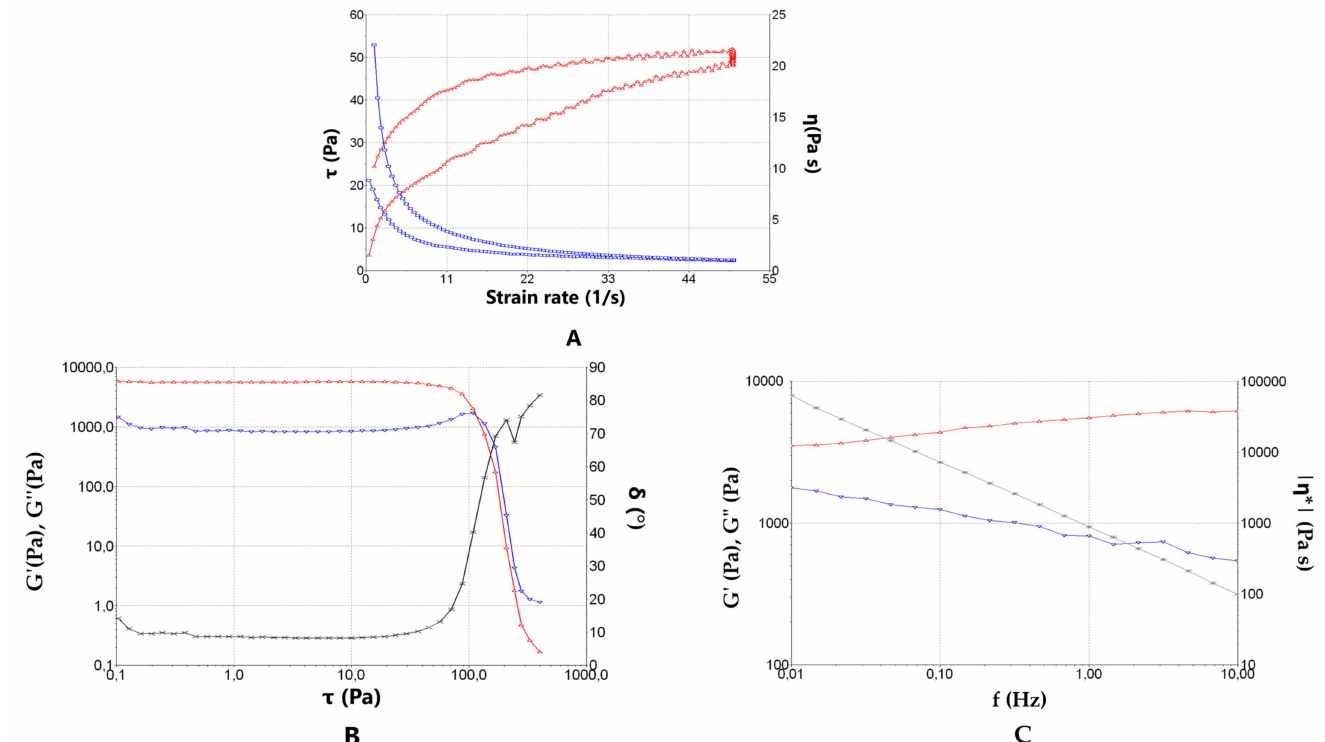
Figure 4. ( A ) Rheogram of PF-NLCs-F127 hydrogel at 25 ◦ C. The flow curve represents shear stress ( τ in Pa) (left axis) or viscosity ( η in Pa · s) (right axis) as a function of the shear rate ( γ in s − 1 ). ( B ) Oscillatory study applied to PF-NLCs-F127 hydrogel at 32 ◦ C. Variation of elastic modulus G (cid:48) ( in red ), viscous modulus G (cid:48)(cid:48) ( in blue ) and the phase angle δ as a function of shear stress τ . (Frequency constant 1 Hz) ( C ) Oscillatory study applied to PF-NLCs-F127 hydrogel, at 32 ◦ C. Variation of elastic modulus G (cid:48) ( in red ), viscous modulus G (cid:48)(cid:48) ( in blue ) and the phase angle δ as a function of shear stress π ( τ constant 1 Pa). The data were obtained from the mean of three experiments ( n =